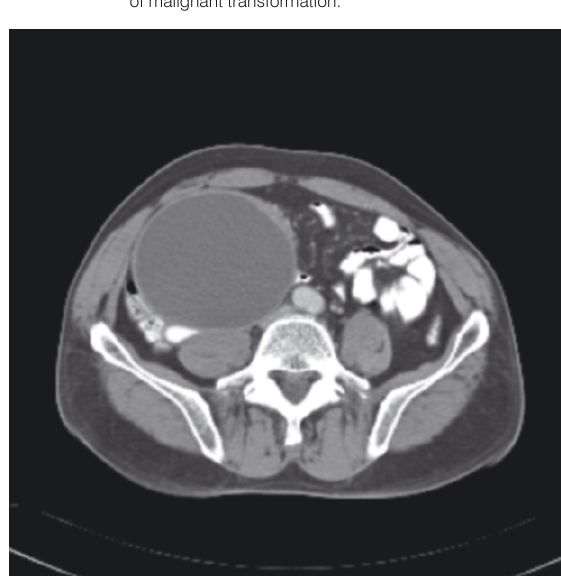
Figure 1. Abdominal computerized tomography scan with contrast. The thickened area in the cyst wall proved to be the focus of malignant transformation.